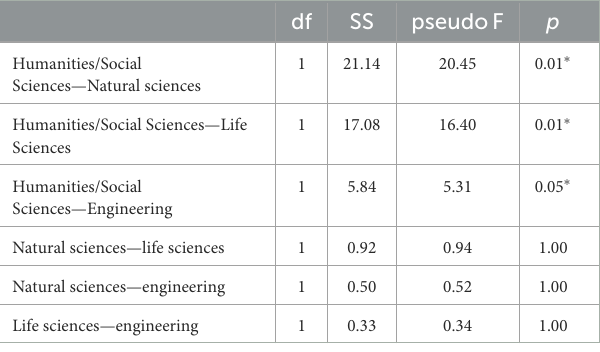
TABLE 5 Pairwise A-posteriori tests between the different disciplinary compositions.